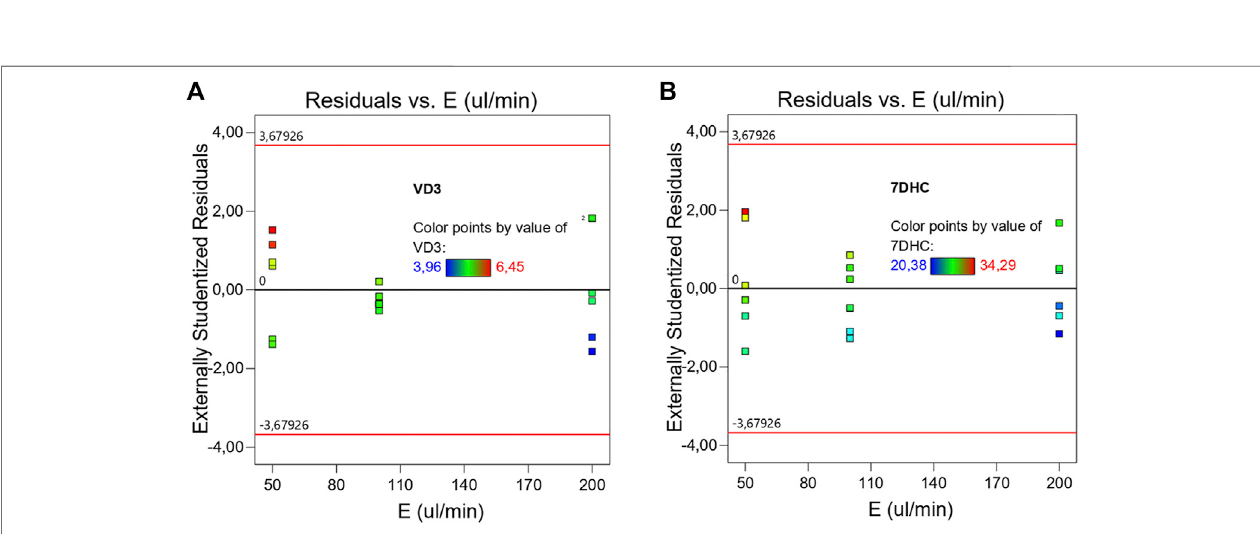
FIGURE4| NormalizedresidualsplotofVD3 (A) and7DHC (B) withrespectofdecompression speed(E).( Averagepointsingreen.Inblueandinredthelowerand the upper leveraged values respectively )